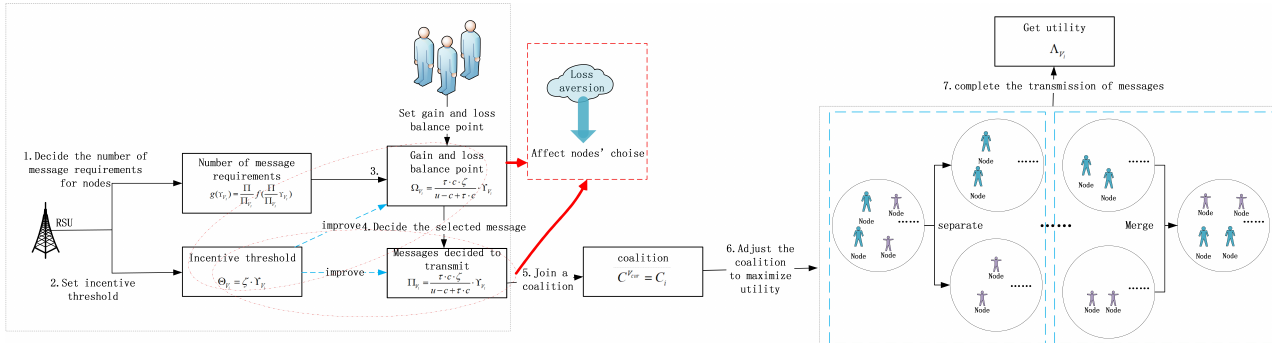
Figure 3. Logical